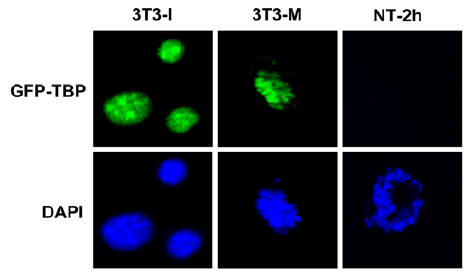
Figure 2. Localization of GFP-TBP in 3T3 cells and NT oocytes. GFP-TBP localized at the nucleus of interphase 3T3 cells and chromosomes of M phase 3T3 cells. However, no GFP-TBP signal was found at the chromosomes of NT